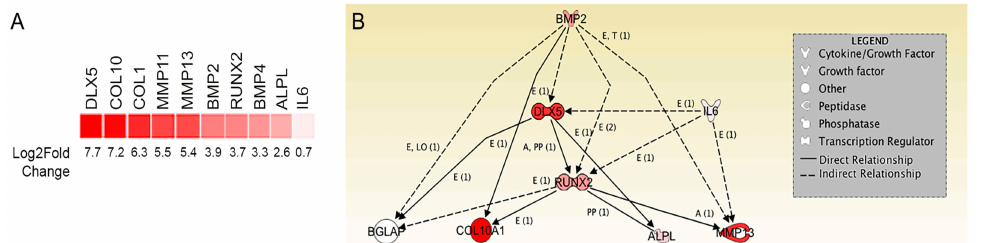
Figure 2. Network of hypertrophy, ossification, and proinflammatory genes that are di ff erently expressed between BM-MSCs and C-PCs. ( A ) Heat map of di ff erential gene expression in BM-MSCs. Results are displayed in increasing order of expression levels based on log2 fold change. ( B ) Ingenuity Pathway Analysis (IPA) software analysis of BM-MSC RNA Seq data illustrates the central role of DLX5 in hypertrophy and ossification pathway networks. The figure legend displays the biomolecular identity of each molecule. Within direct pathways, E = regulates expression levels, T = a ff ects transcription levels, PP = protein to protein interactions, LO = left out but indicates gene a ff ects expression.